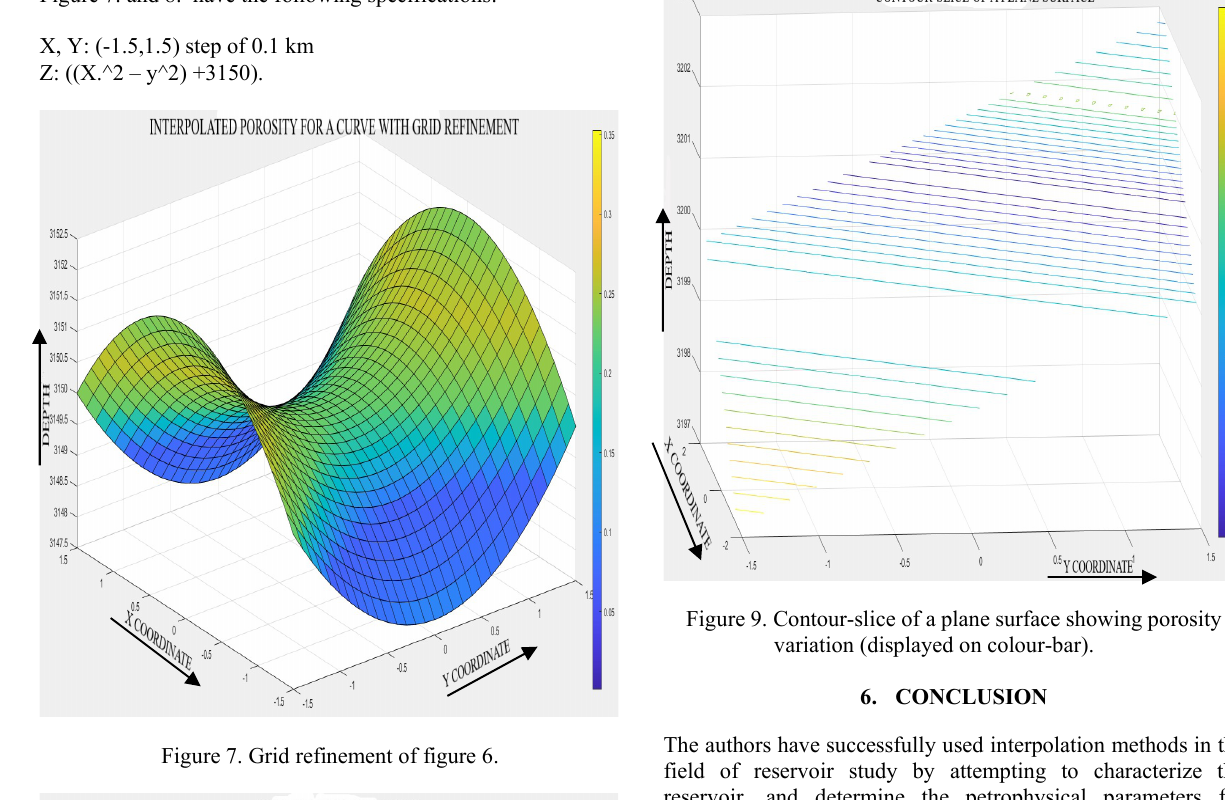
Figure 7. and 8. have the following specifications: X, Y: (-1.5,1.5) step of 0.1 km Z: ((X.^2 – y^2) +3150).